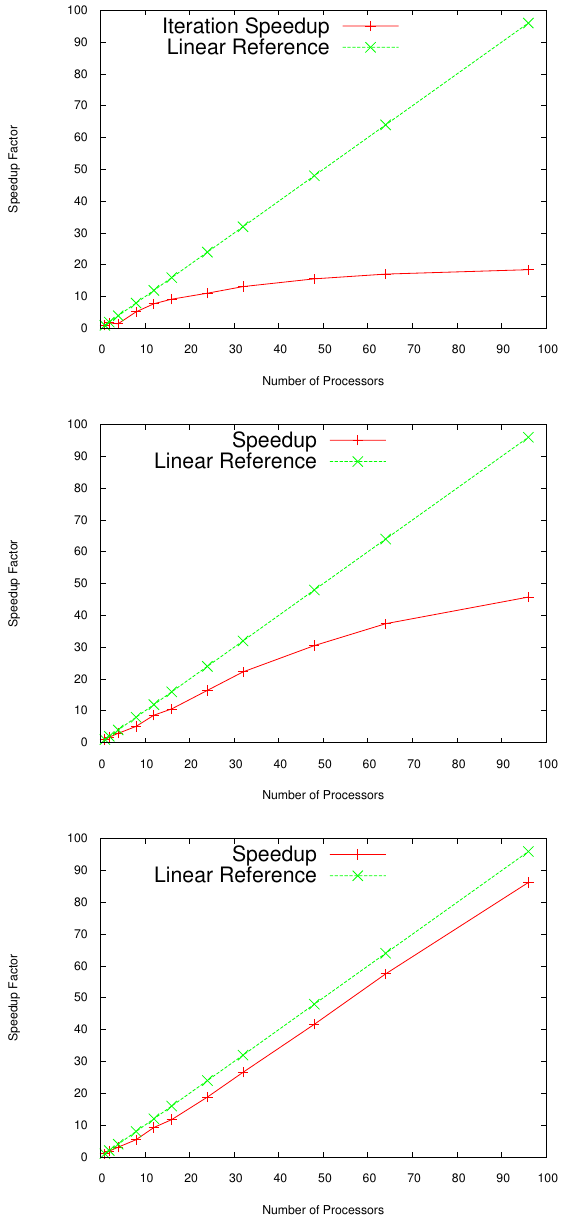
Fig. 10. Scalability results based on number of generators. Green is a linear reference whereas red is the speedup computed using the parallel version of MPI-SCVT compared to a serial